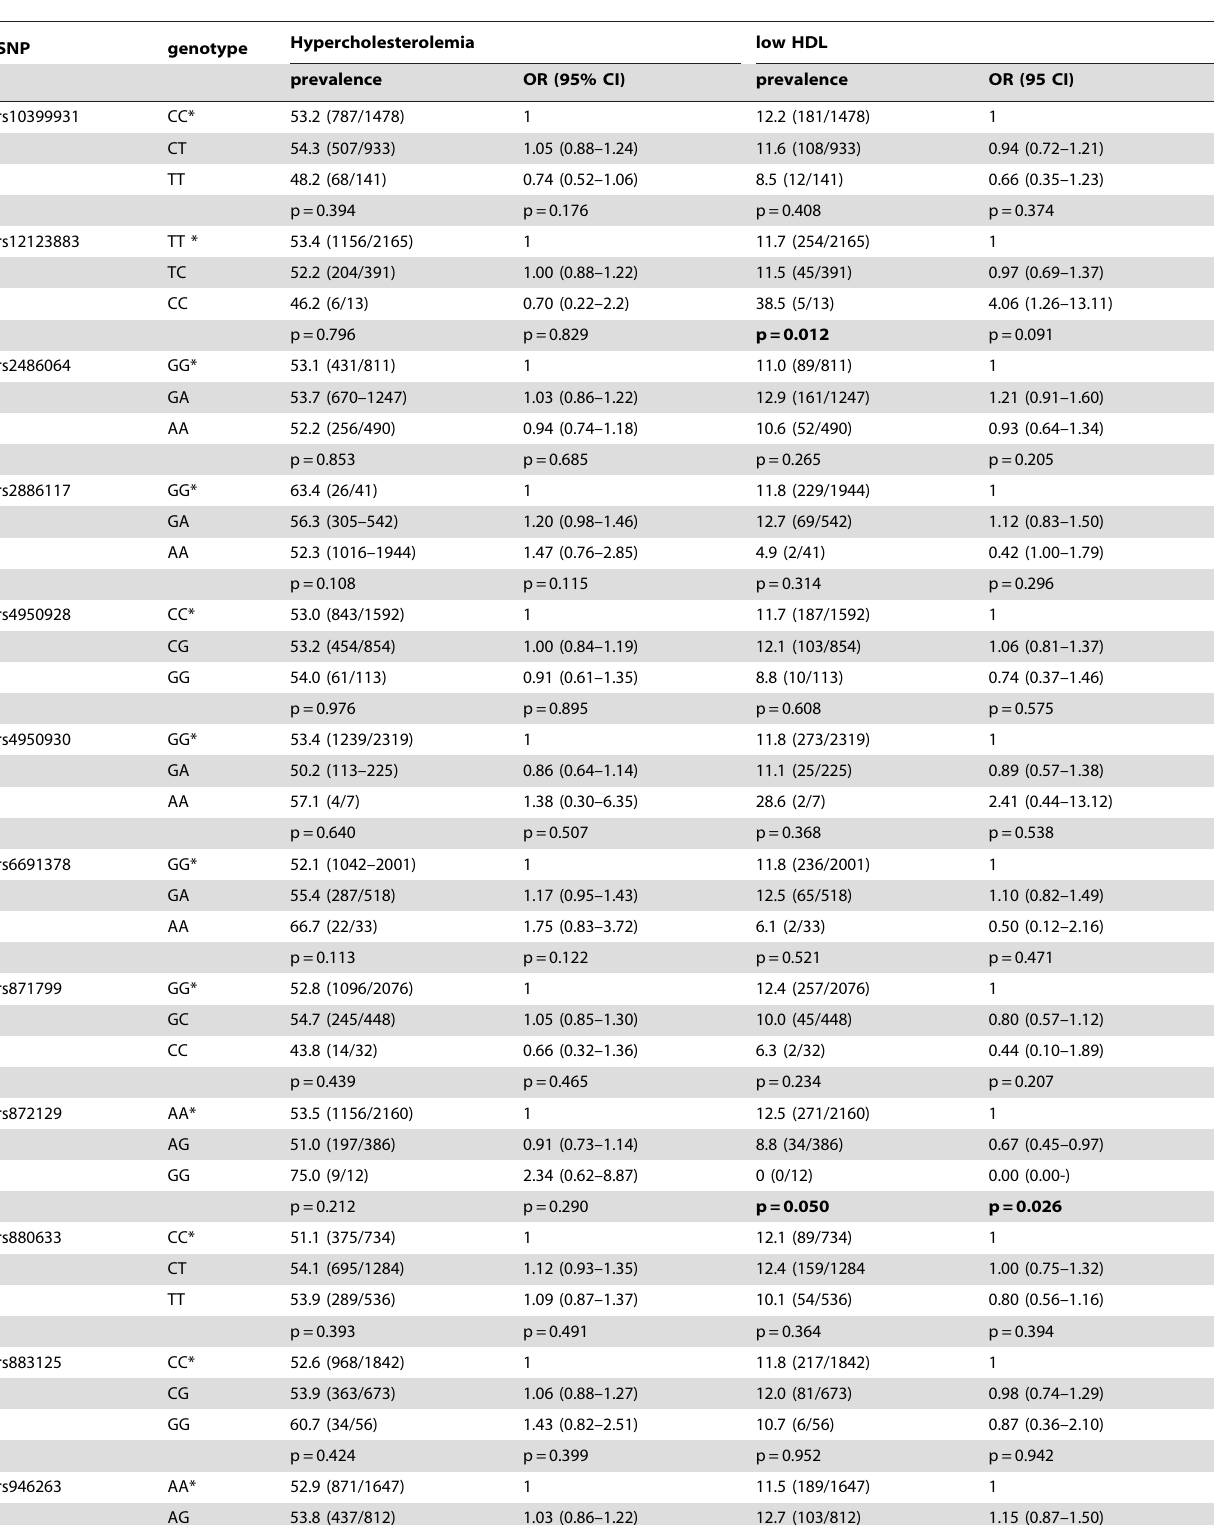
Table 3. Prevalence and risk (odds ratio (95% confidence interval)) of hypercholesterolemia and low HDL at baseline according to single nucleotide polymorphisms (SNPs) of CHI3L1 in